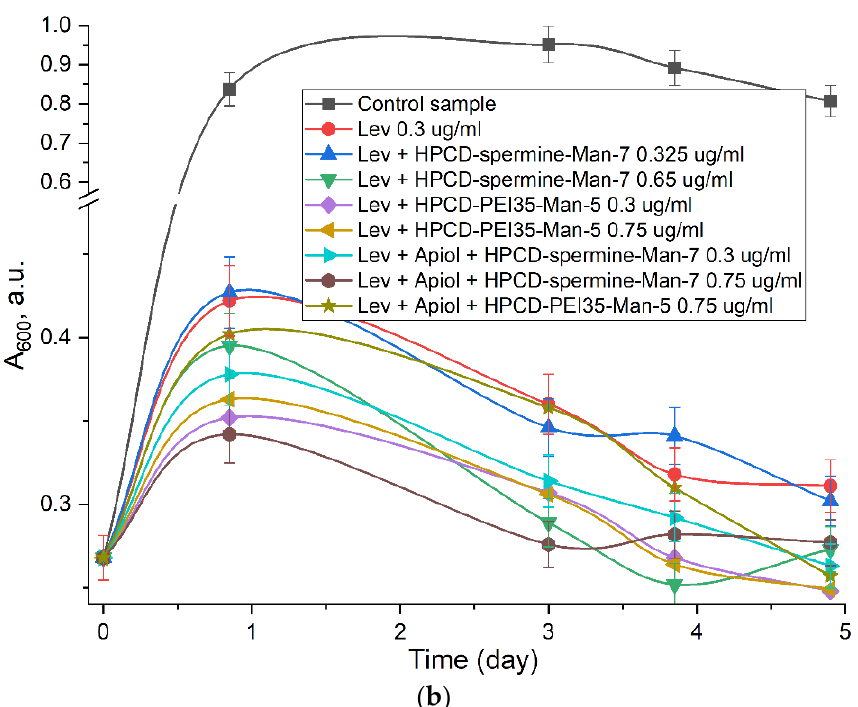
Figure 8. The dependence of the optical density A 600 (correlate with CFU) on the incubation time of E. coli cells (NCIB 12210) with drugs. ( a ) In all samples C(Lev) = 5 μ g/mL ( b ) C(Lev) = 0.3–0.75 μ g/mL are indicated in the figure. Molar ratio of Lev:apiol and Lev:EG is equal to 1:1. pH 7.4 (0.01 M PBS), 37 °C, 24 h of incubation. Values are presented as the mean ± SD of three experiments.